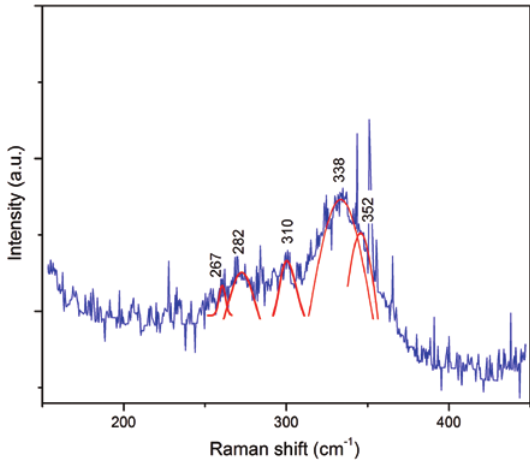
Figure 3: Raman spectrum of the as-synthesized